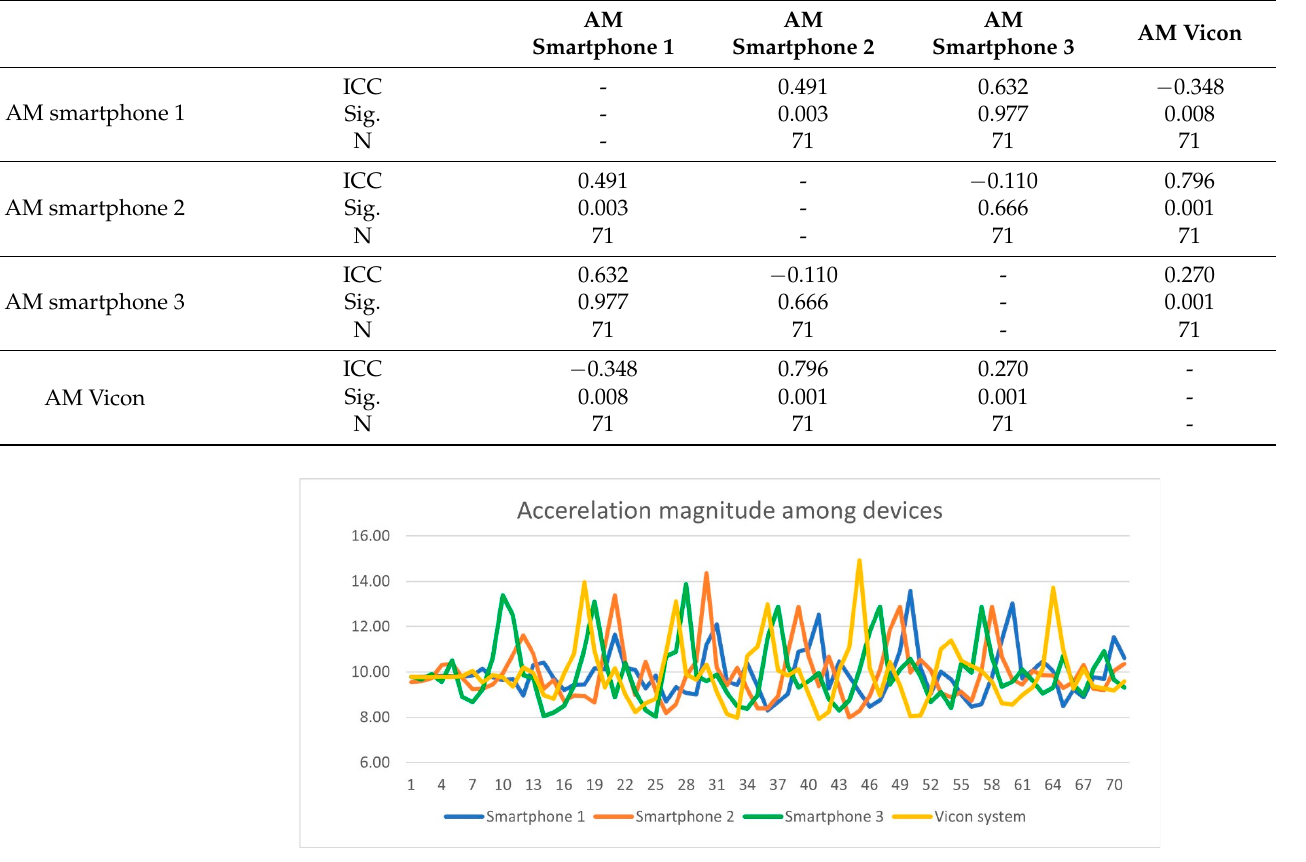
Table 6. Intraclass Correlation Coefficient values among device’s acceleration magnitude.